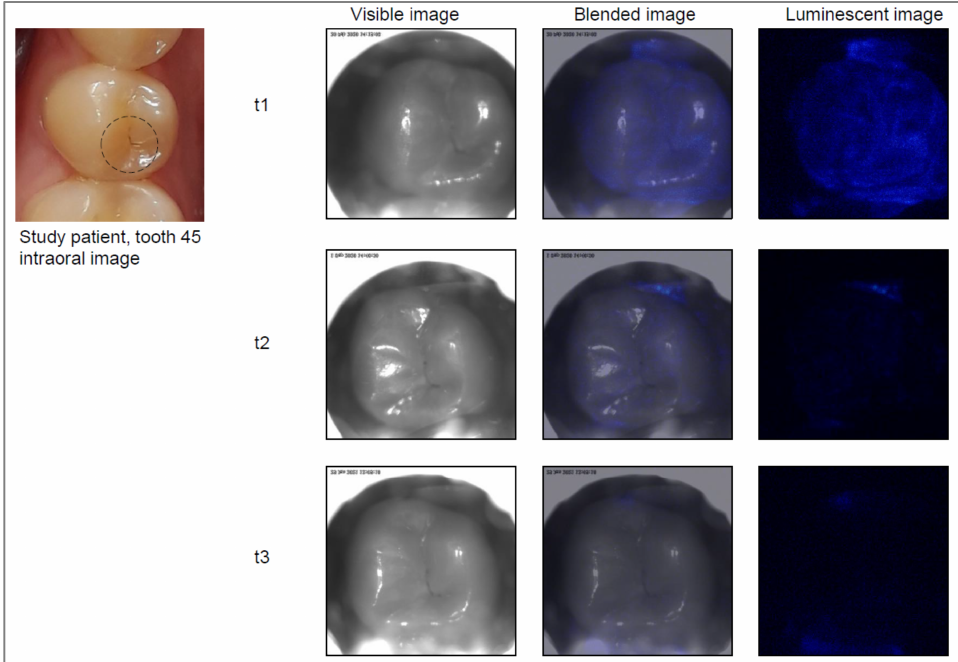
Figure 5. Example of a study tooth (lower right premolar) with an inactive lesion. At t1, a biolumines- cence signal was visible all over the occlusal surface, whereas at t2 and t3, no signal was detectable in the